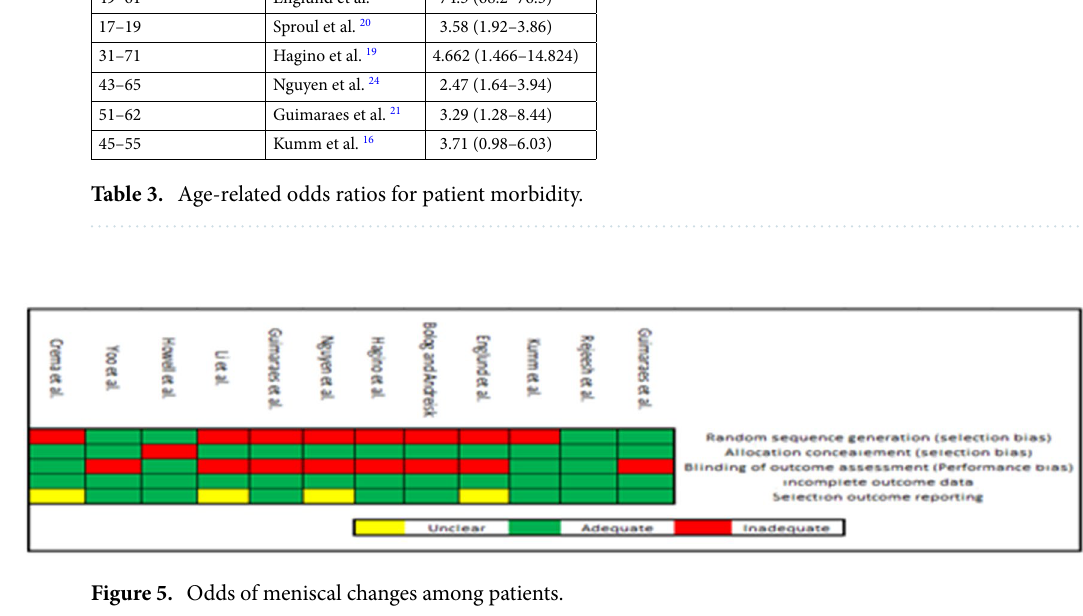
Figure 5. Odds of meniscal changes among